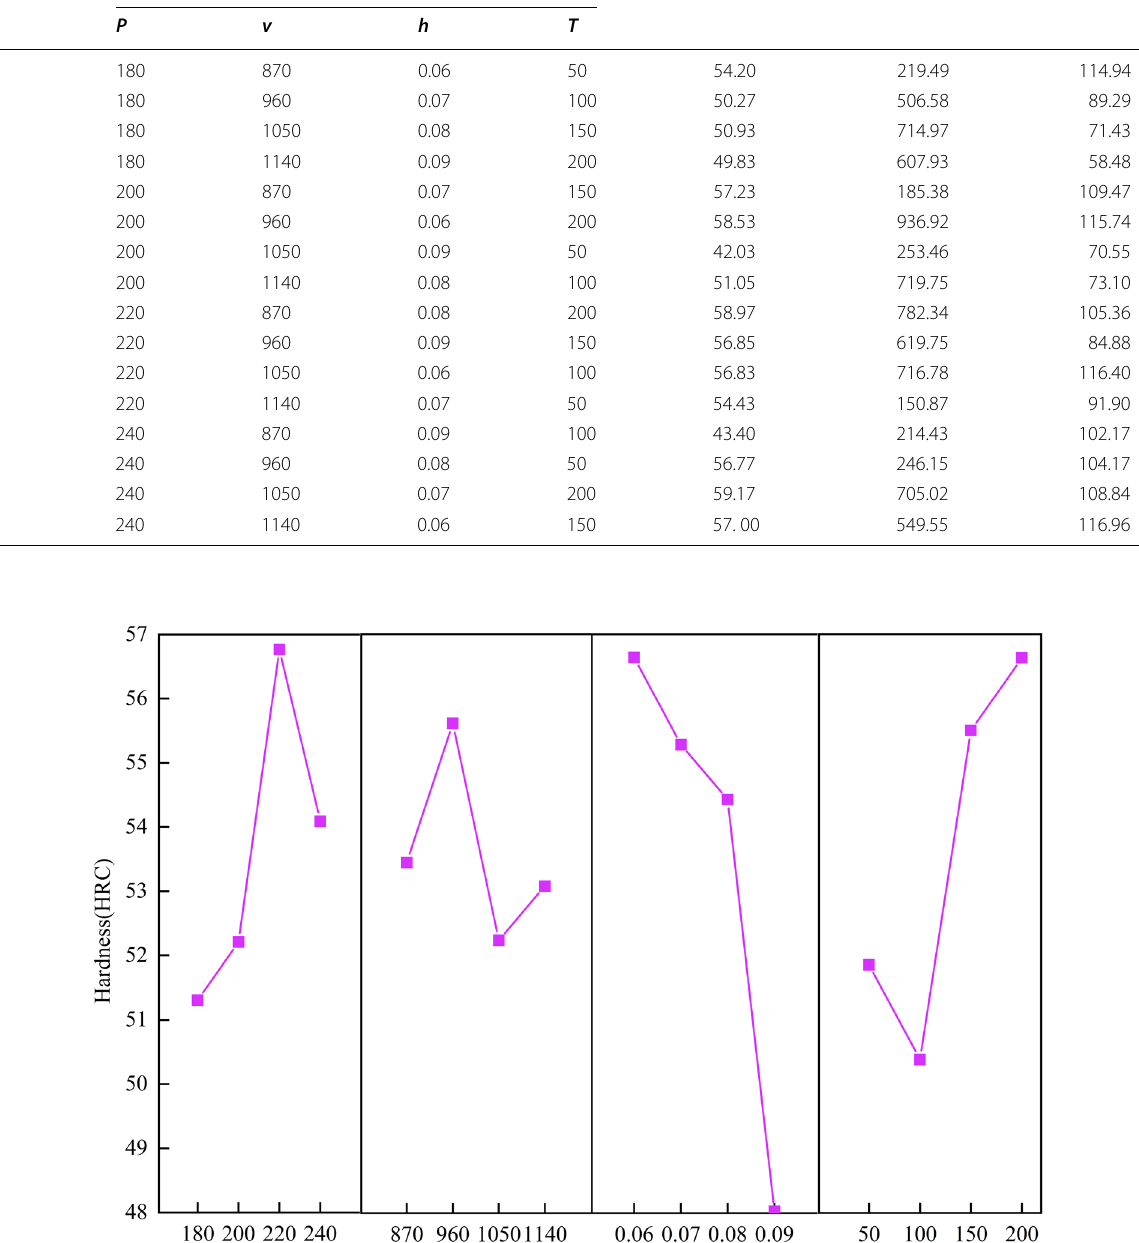
laser power, scan speed, and substrate temperature have a feeble influence on the hardness reduction, ensur- ing that the hardness of the sample reaches a higher level. Moreover, the hardness values always maintained